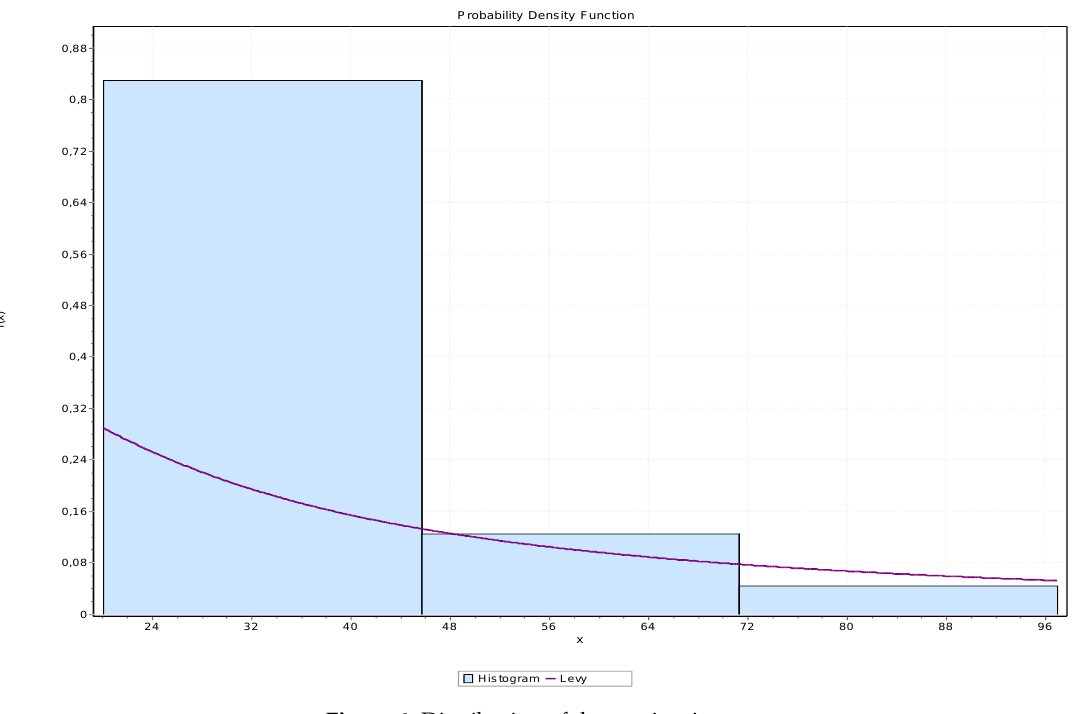
Figure 6. Distribution of the service time.